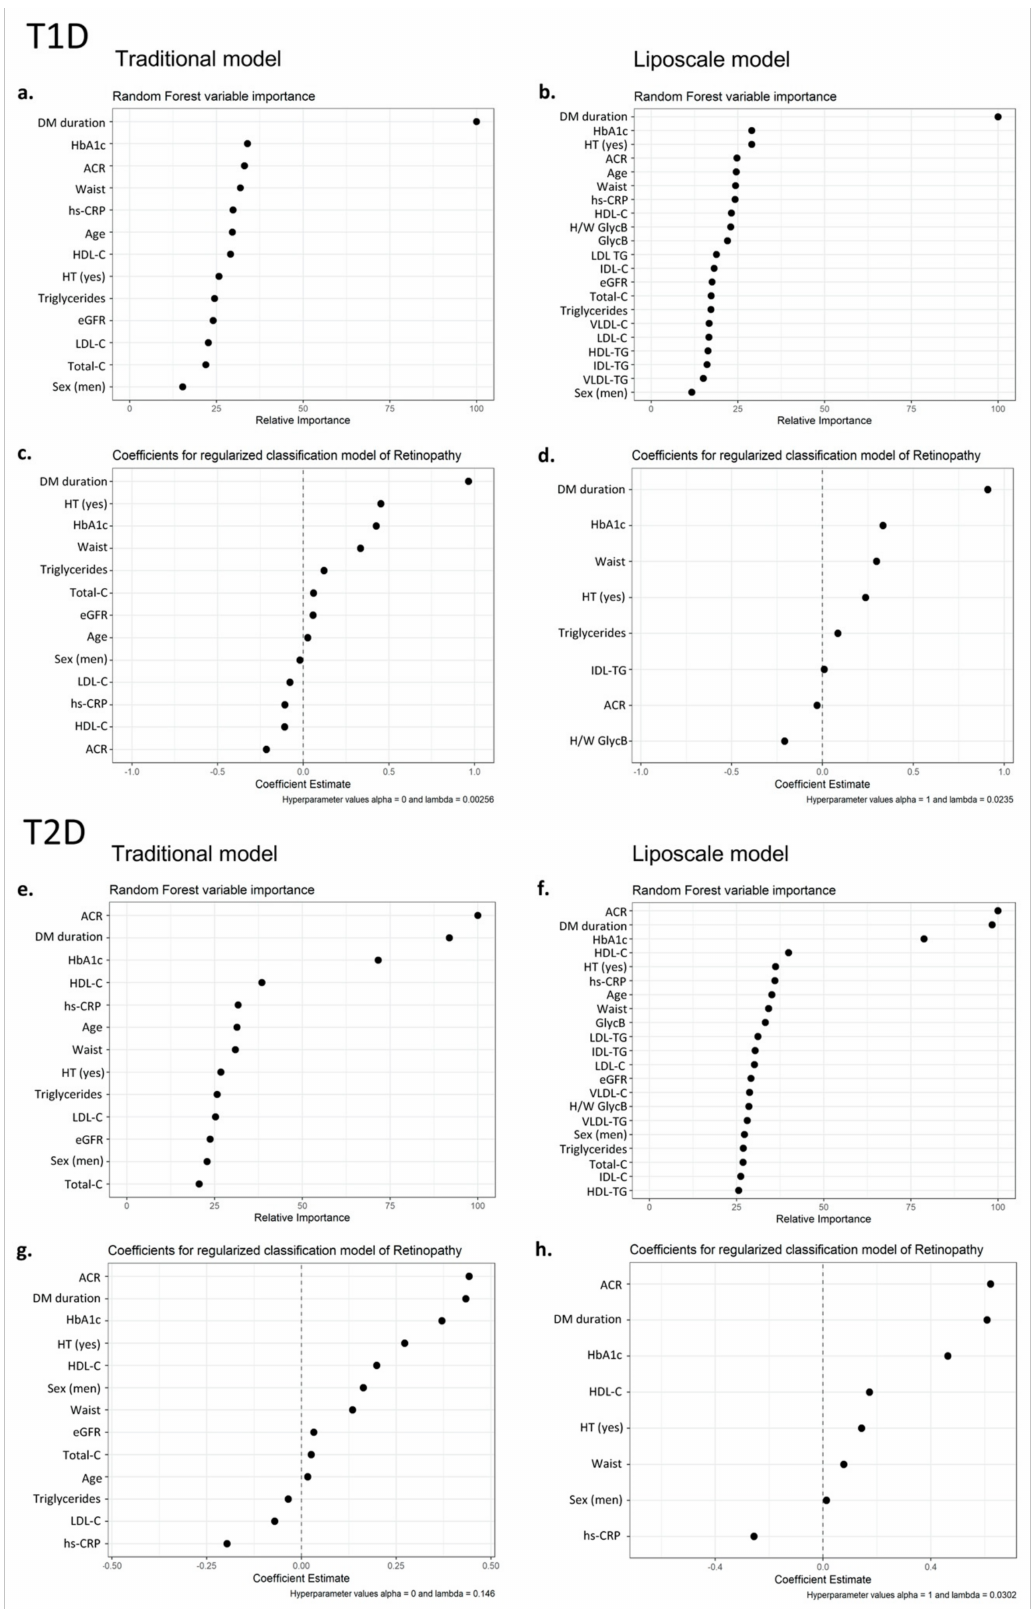
Figure 1. Traditional and Liposcale models to predict the presence of DR in T1D and T2D groups. In the T1D group, random forest analysis for Traditional ( a ) and Liposcale ( b ) models, and regularized logistic regression analysis for Traditional ( c ) and Liposcale ( d ) models. In the T2D group,